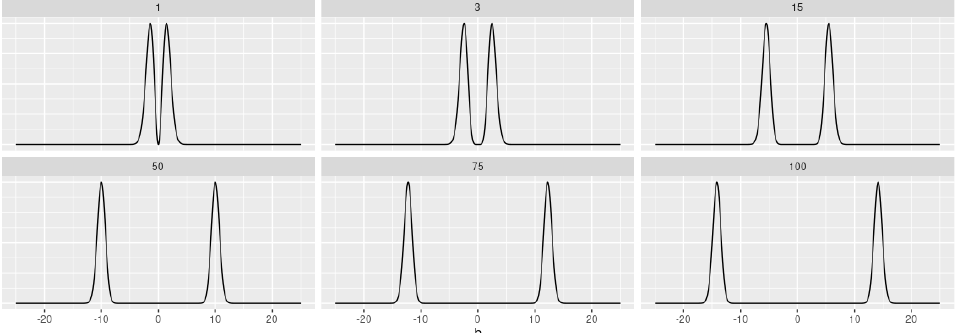
Figure 1. Density function of the BN distribution by varying the parameter k (displayed at the top of each